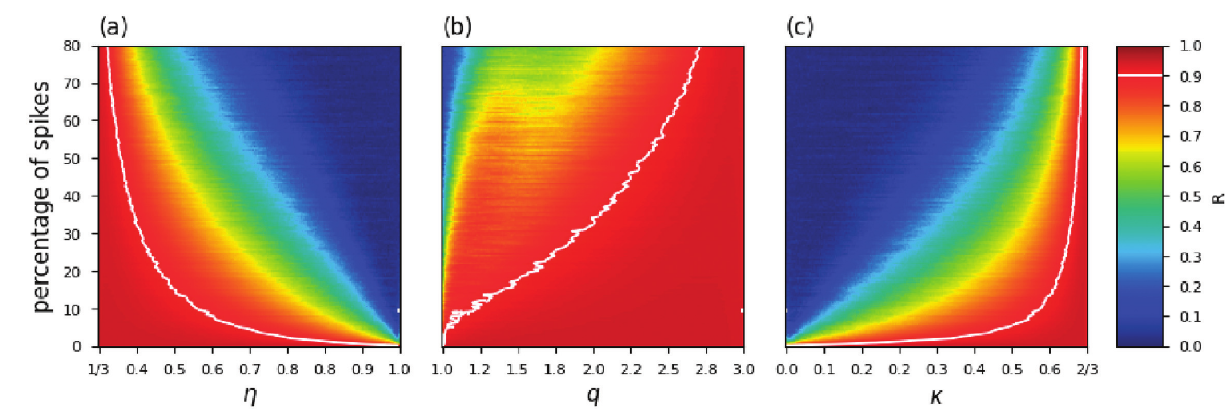
Fig 14. Heat-map representing the correlation between synthetic and recovered impedance models for the objective functions: (a) Re´nyi, (b) Tsallis and (c) Kaniadakis. The white markings indicate points such that R = 0.9 (strong correlation).